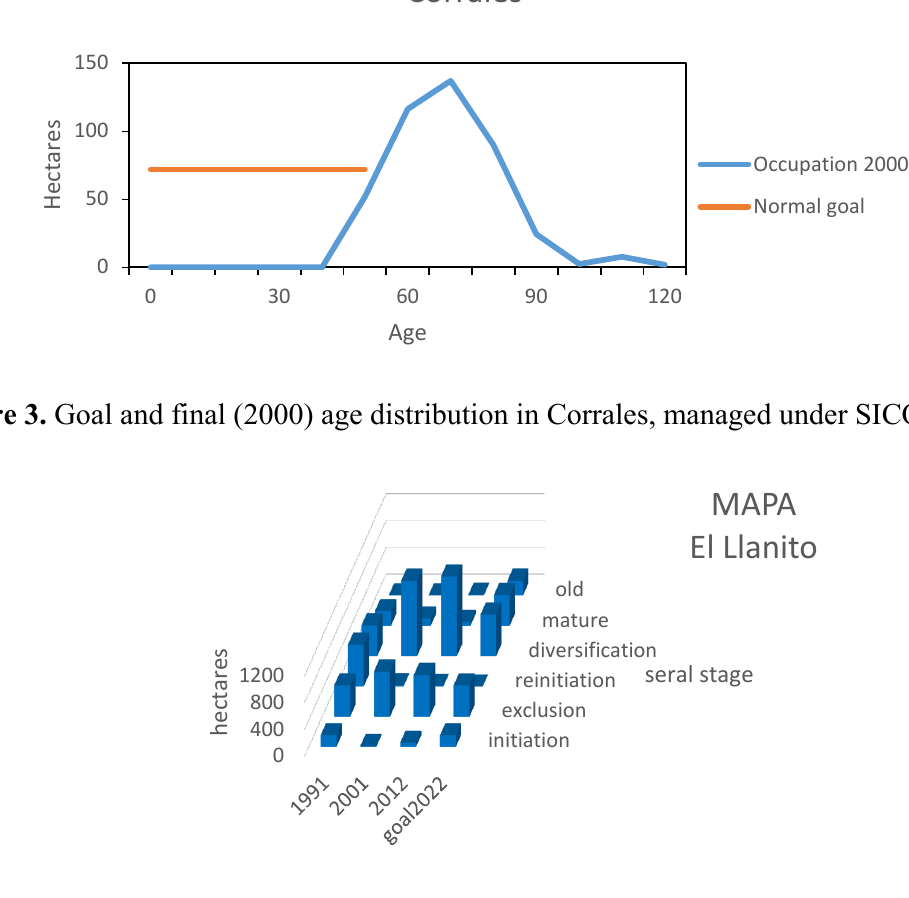
Figure 4. Starting (2002), residual (2012), and forecasted abundance of seral stages in El Llanito y cuatro más, managed under